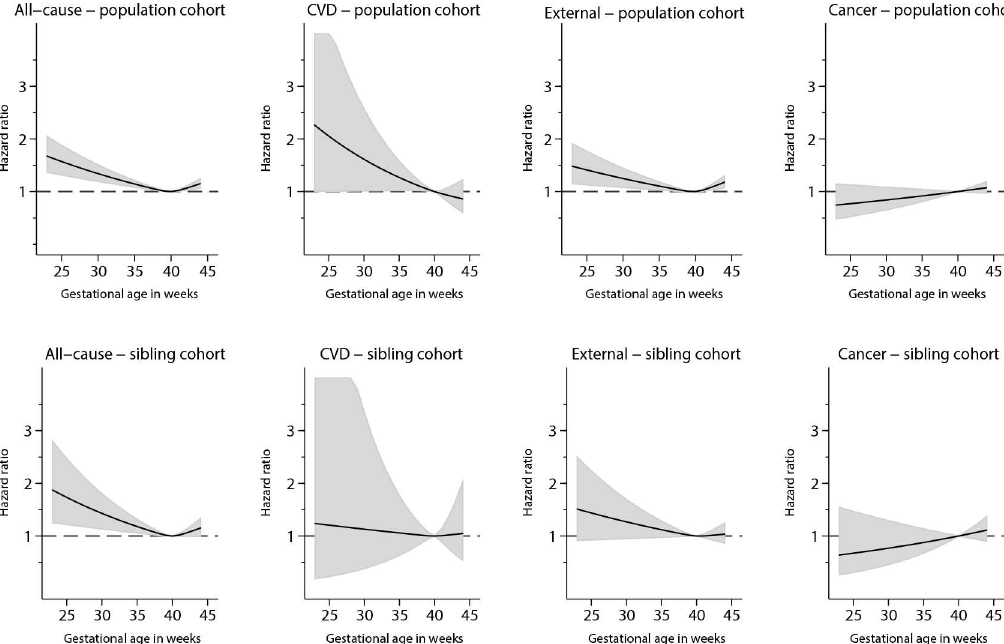
Fig 1. All-cause mortality and main categories of mortality risks (adjusted Hazard Ratios with 95% Confidence Intervals) according to gestational age at birth (completed weeks), in population (upper row) and sibling cohorts (lower row). Nation-wide cohort born in Norway